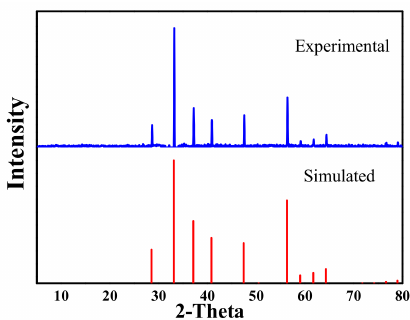
Figure 1. X-ray diffraction (XRD) pattern of the pyrite